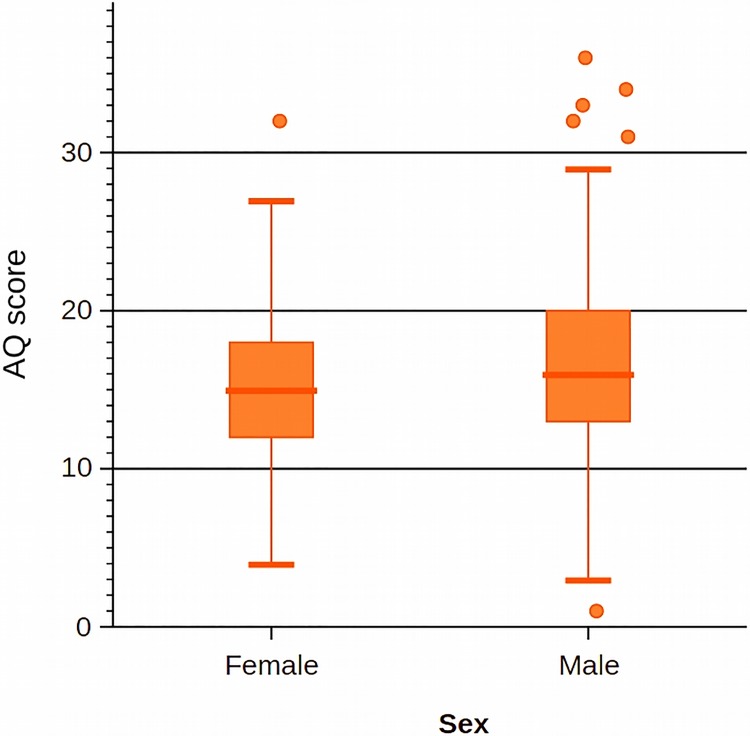
Box plot showing the differences between male and female subsamples.Whiskers and box bands denote quartiles.Comparison using Student’s t-test for independent samples showed that males scored higher than females (t(591) = 4.655, p <0.001), meaning that the magnitude of autistic traits was higher in the former.